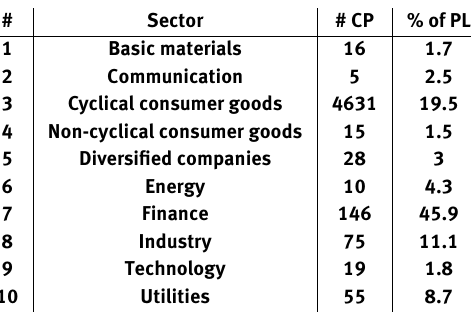
Table 1. Economic